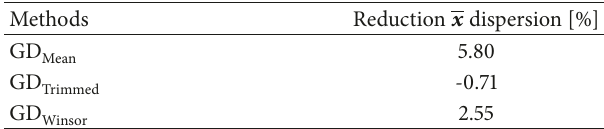
Table 30: Exponential with 20 points.